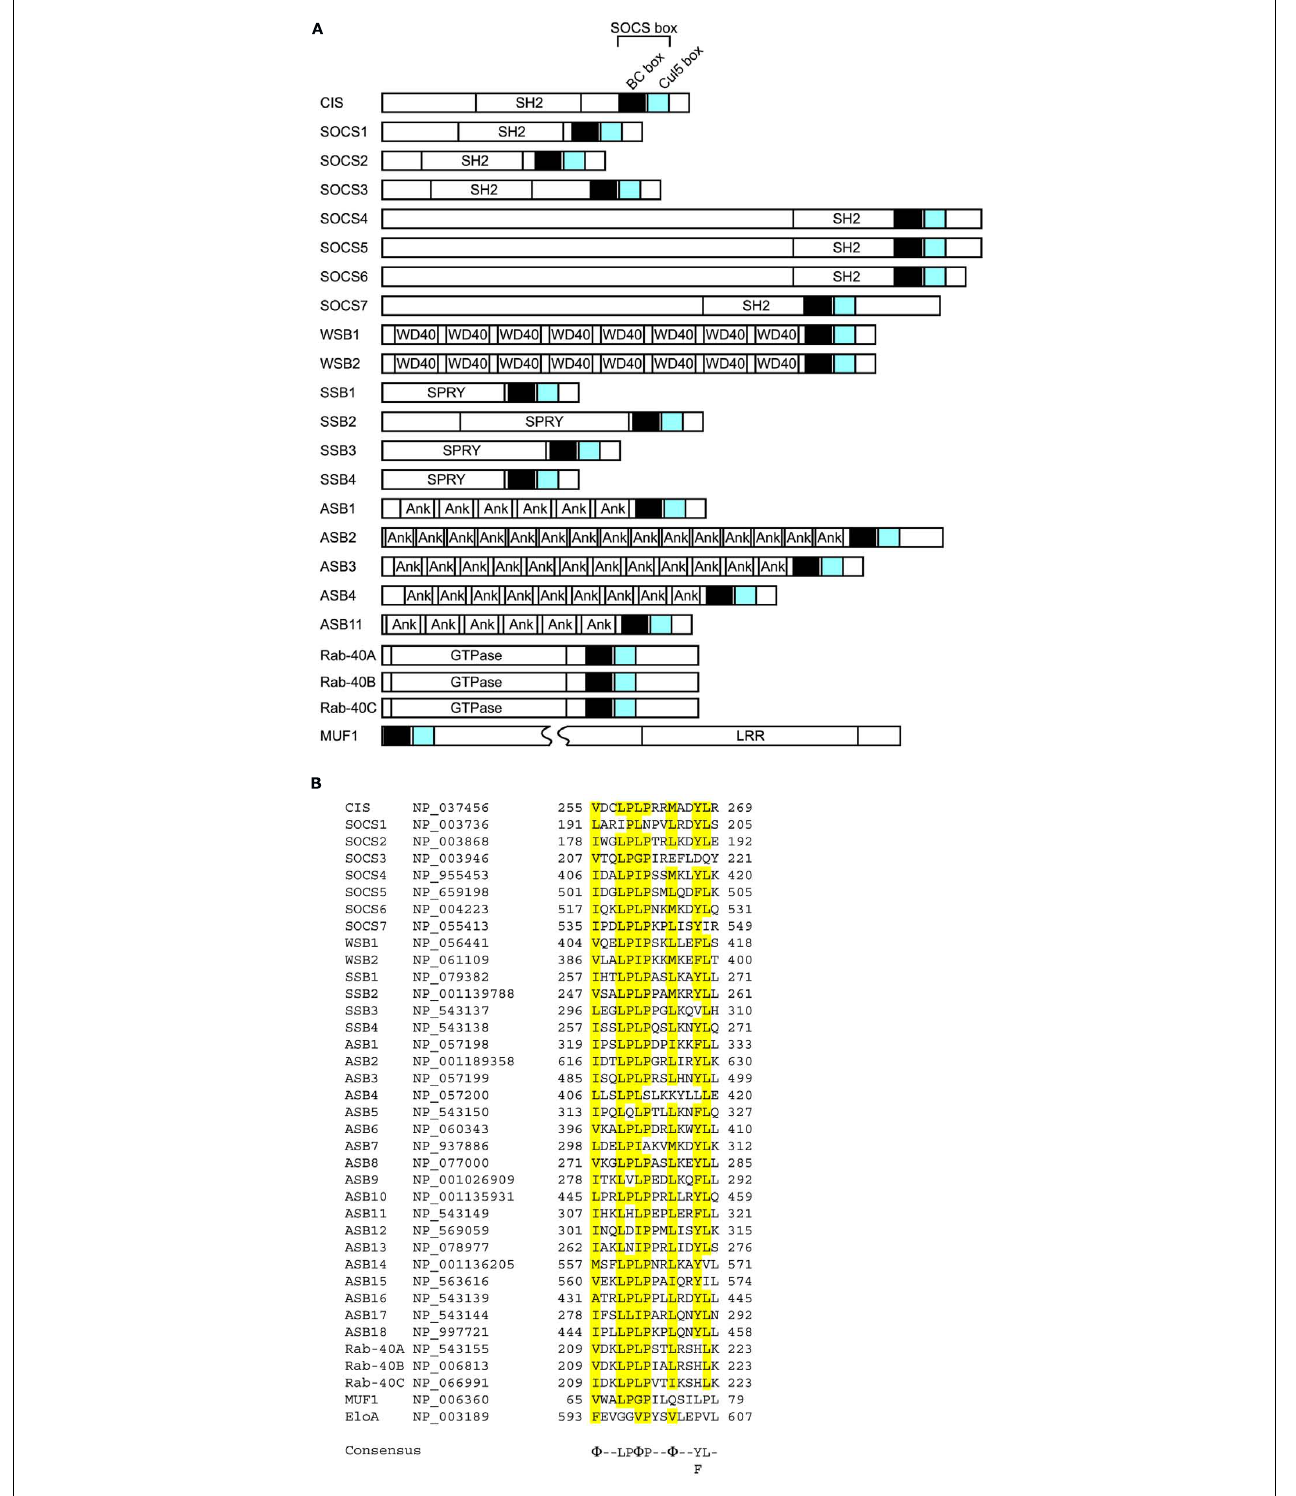
repeats; GTPase, GTPase domain. (B) Alignment of amino acid sequences of selected Cul5 boxes. Identical amino acids are highlighted in yellow. GenBank™accession numbers of each protein are indicated.The consensus sequence is indicated below. Φ , hydrophobic residue.